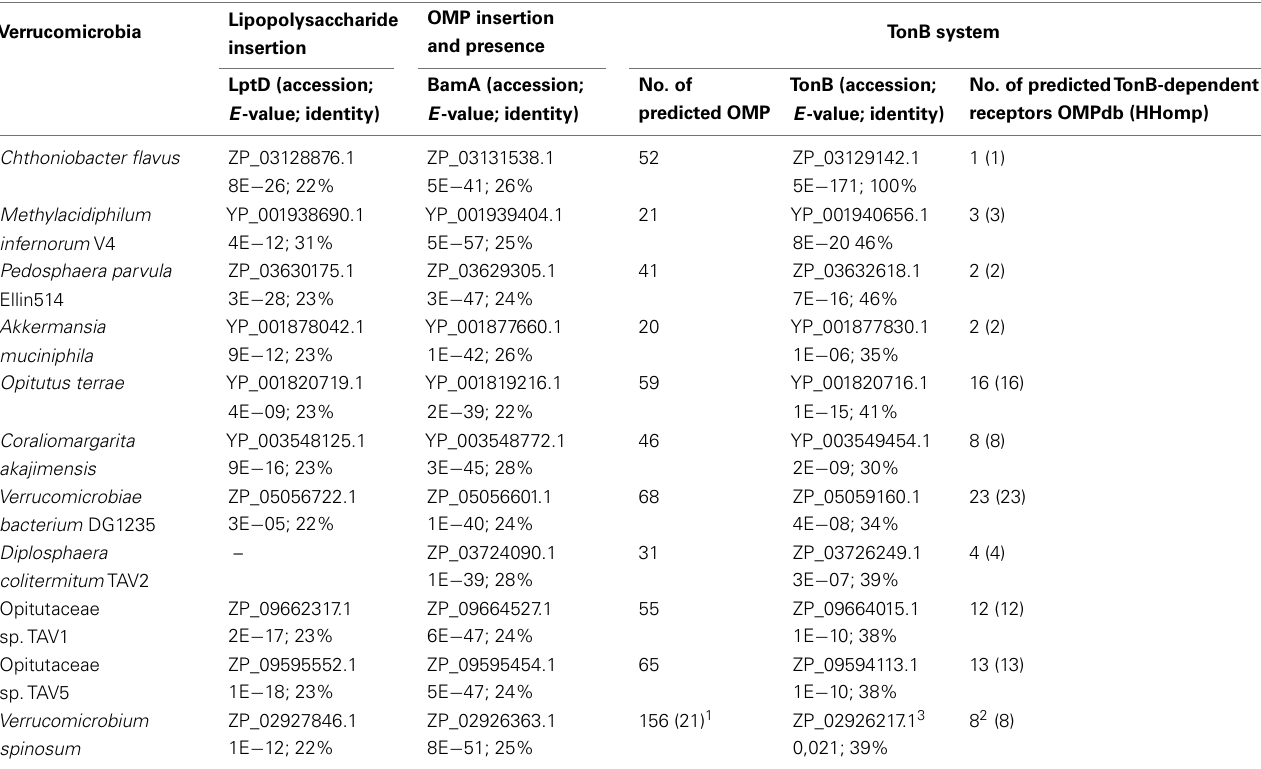
Table 2 | Presence of outer membrane biomarkers in genomes of Verrucomicrobia.